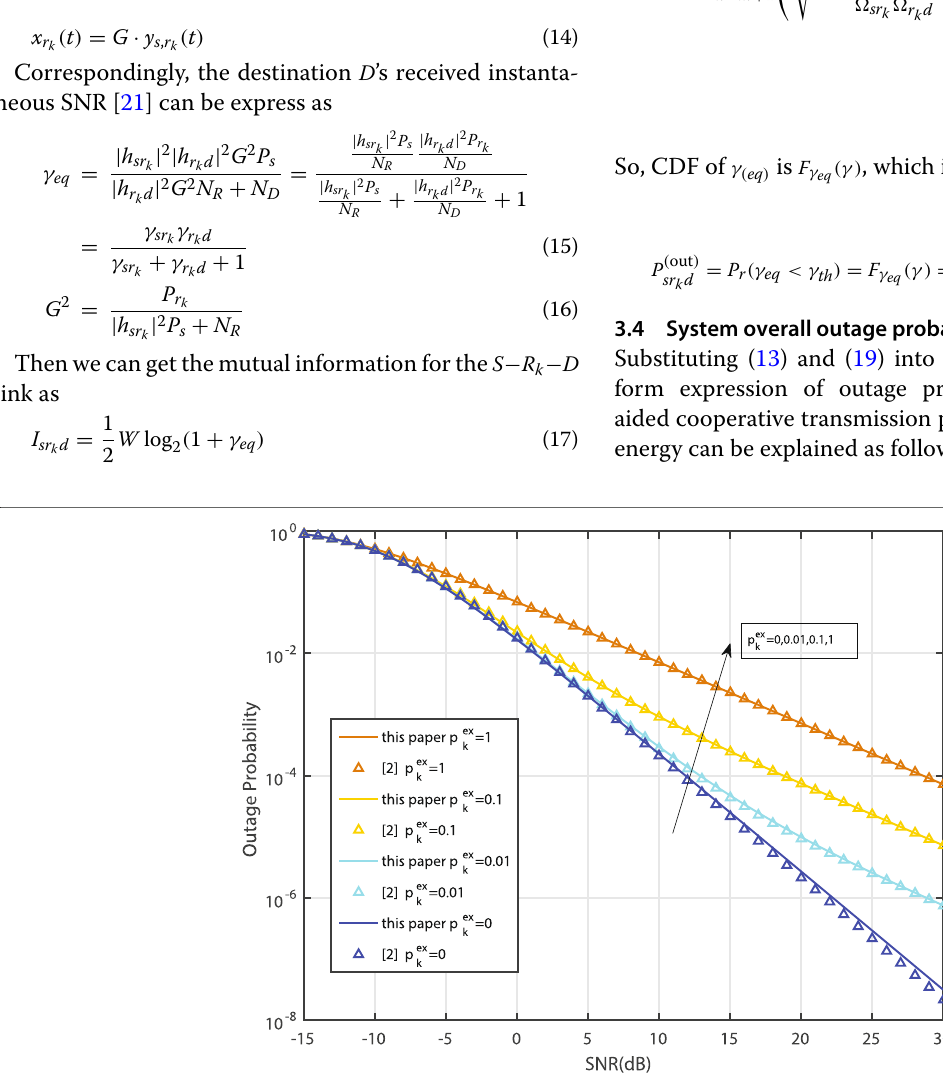
= 1, m = 1, r k d r k